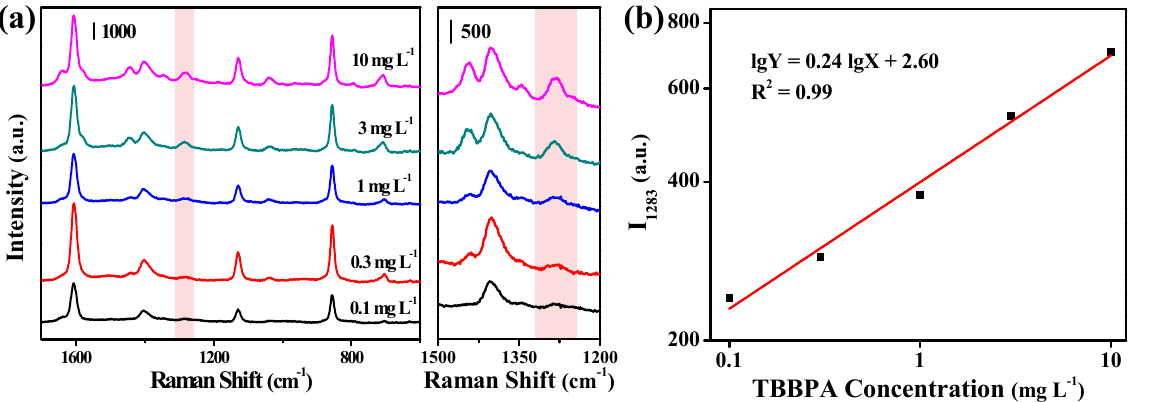
Figure 4. ( a ) SERS spectra of TBBPA in the different concentrations obtained from the hydrophobic Ag-Cu chips. ( b ) Standard curve for quantitative SERS detection of TBBPA from the hydrophobic Ag-Cu chips.